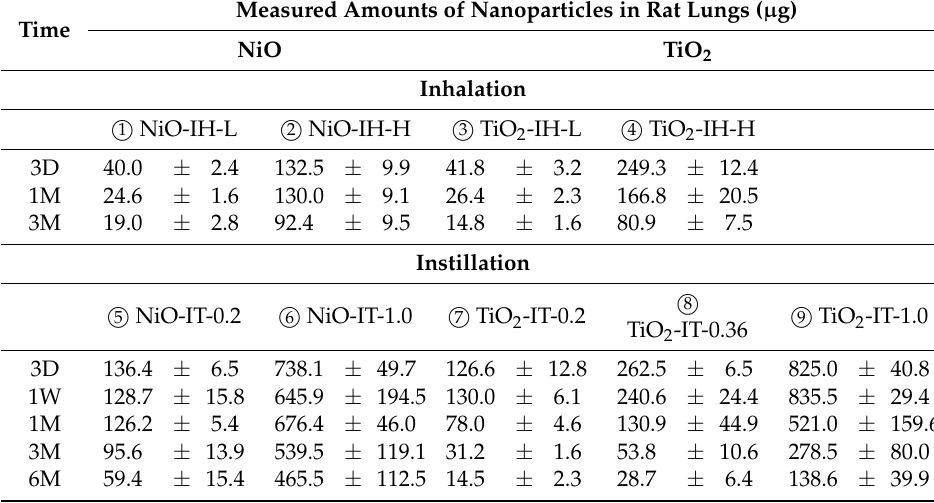
Table 1. Measured particle amounts in rat lungs.